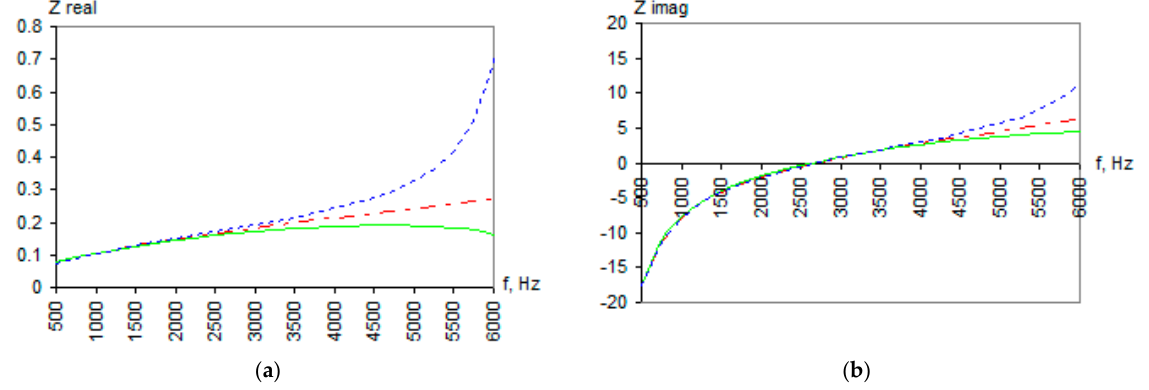
Figure 7. Normalized impedance determined by the Formula (1): ( a ) Real part; ( b ) Imaginary part; Variant 1 of the orifice arrangement; Variant 2 of the orifice arrangement; Variant 3 of the orifice arrangement.